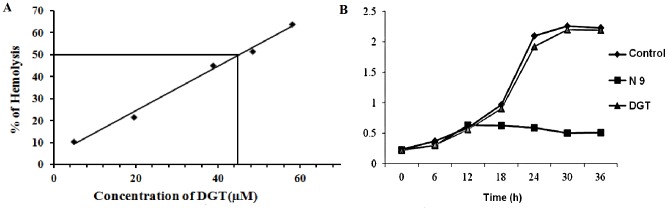
Irritation potential as measured by hemolytic activity and effect on Lactobacillus acidophilus in vitro.(A) Dose-dependent effect of DGT in rat RBCs. Isolated RBCs were incubated with varying drug dilutions, Triton X-100 and PBS. The extent of hemolysis was determined spectrophotometrically. (B) Effect of desgalactotigonin (DGT) and nonoxynol-9 on Lactobacillus acidophilus. [Optical density as the measure of turbidity denoting growth of bacterial colonies during 36 h of culture in the absence (control) and presence of DGT. There was a gradual increase in the growth of colonies that reached a plateau after 24 h of culture. Irrespective of the dose of DGT (19×MEC), the growth of bacterial colony was comparable with that of the control. N-9, however, exerted constant inhibition of bacterial growth throughout the entire culture period.]